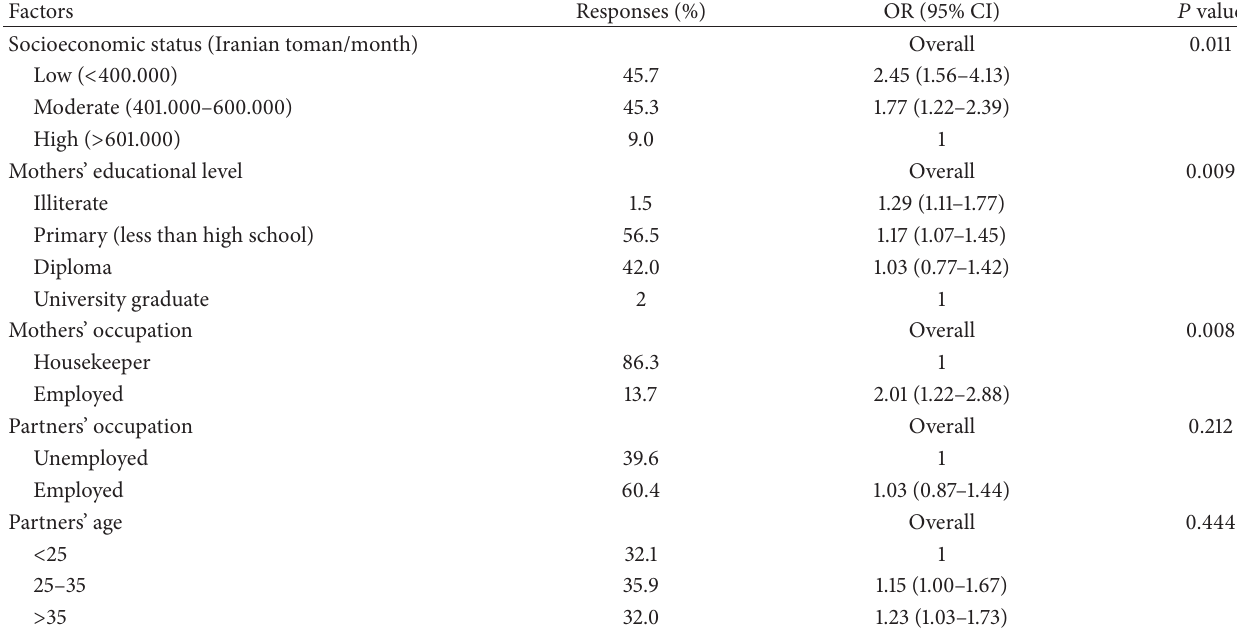
Table 1: Univariate odd ratios (ORs) for sociodemographic characteristic risk factors of postpartum depression.